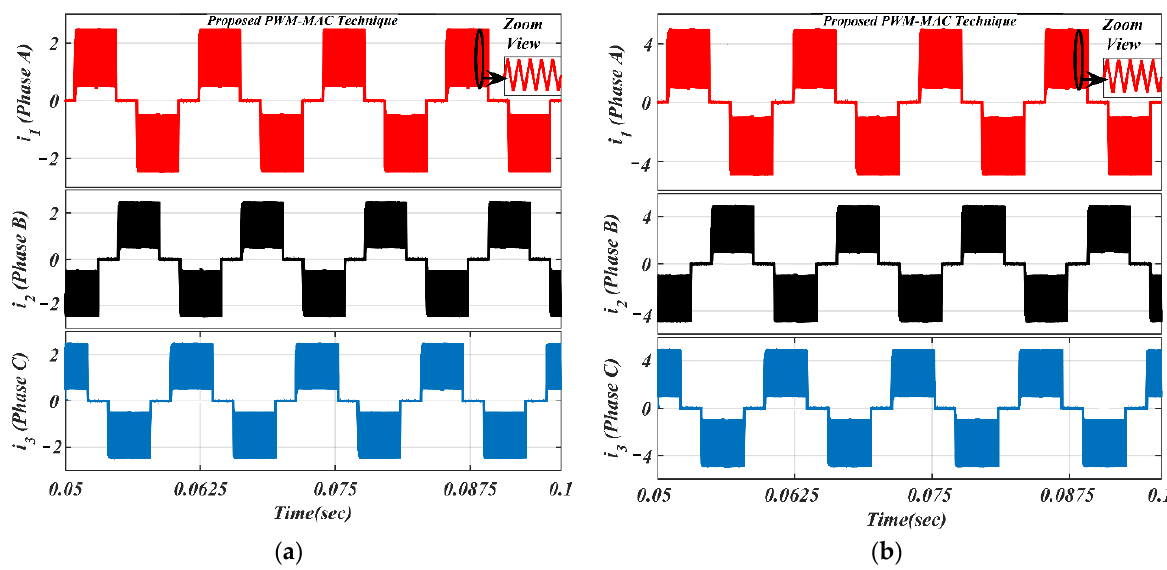
Figure 14. Simulated waveforms of the phase current based on proposed PWM scheme: ( a ) lightly loaded or partially loaded (40% of maximum load); and ( b ) full load (85% of maximum load).